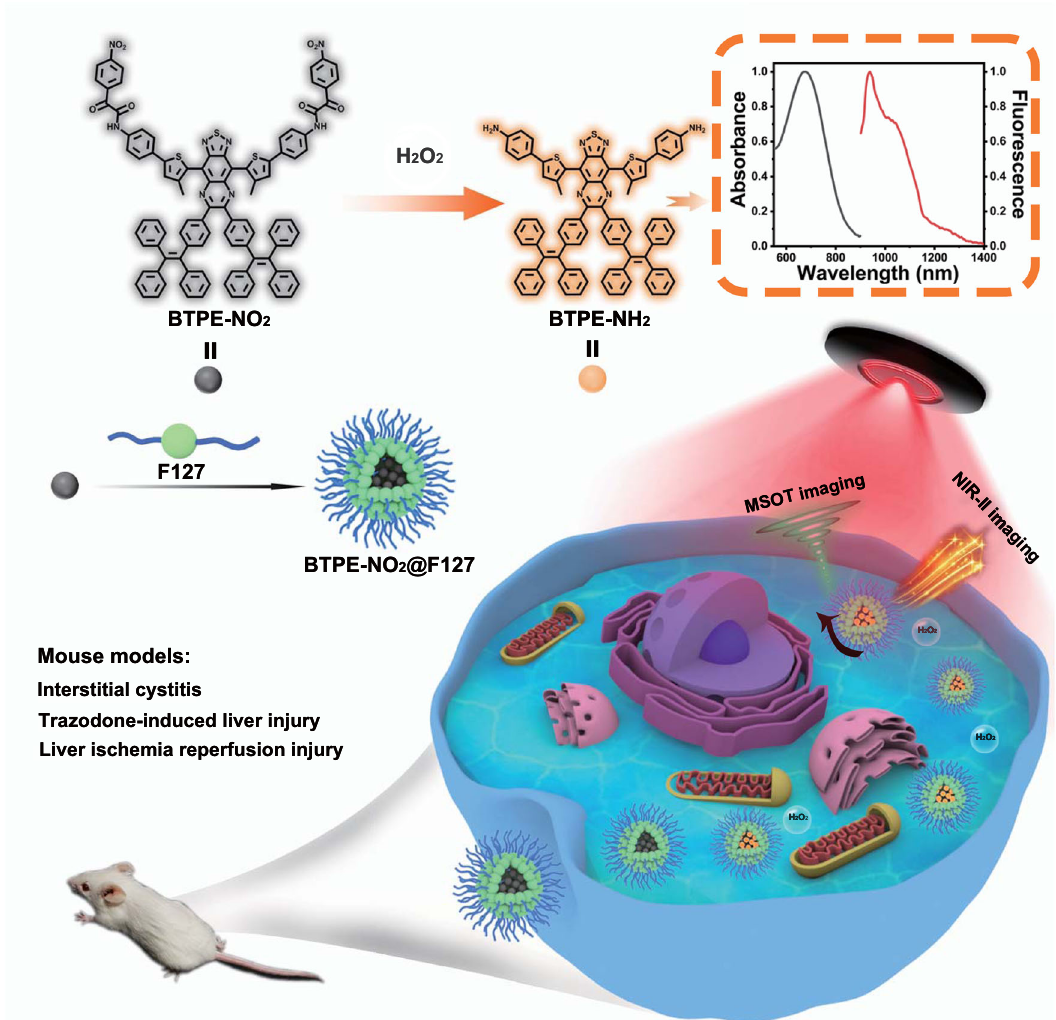
Fig. 1 Schematic representation for the fabrication of nanoprobe BTPE-NO 2 @F127 and its applications. The fabrication of the nanoprobe BTPE- NO 2 @F127 and the biomarker (H 2 O 2 )-activatable detection/imaging for the interstitial cystitis, the trazodone-induced liver injury and the liver I/R injury in mouse